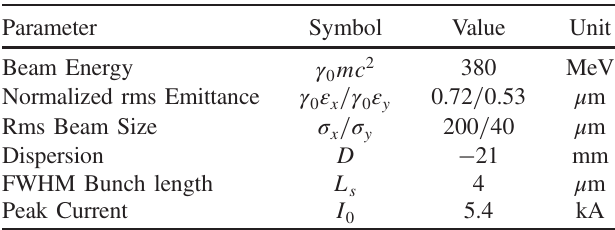
TABLE II. The results of the LPA beam tracking.